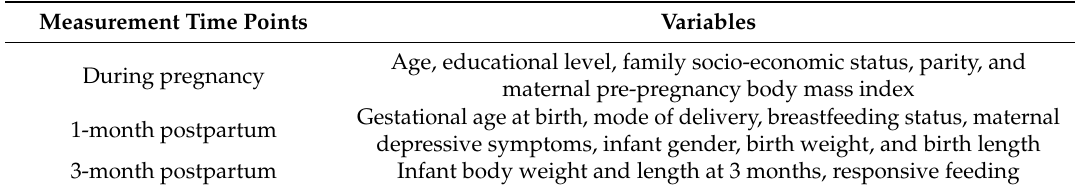
Table 1. Study variables and their time point of data